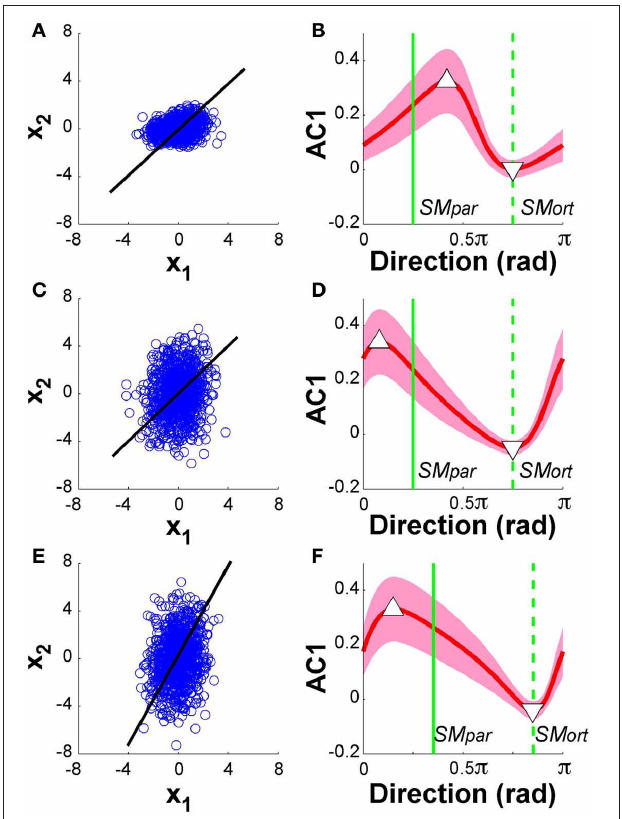
FIGURE 11 | Model analysis with one of the two execution variables scaled. The left panels show the data distributions of 1000 simulation runs plotted in execution space. The black line denotes the solution manifold. The right panels summarize the results of the autocorrelation analysis plotted as a function of direction. The red lines with the shaded bands represent the mean and standard deviations across 1000 simulations for each of the 100 directions; the green vertical lines denote the parallel and orthogonal direction of the solution manifold. Panels (A) and (B) show the simulation results with SM: x 1 = x 2 , α = 0 . 5; panels (C) and (D) shows results with SM: x 1 = x 2 , α = 2; panels (E) and (F) show the case of SM: x 1 = 2 x 2 and α = 2. In all cases, the minima and maxima of the autocorrelations, marked by triangles, have shifted away from the orthogonal and parallel directions of the solution manifold. The simulations in panel (D) show very similar results to the experimental data in Figure 5